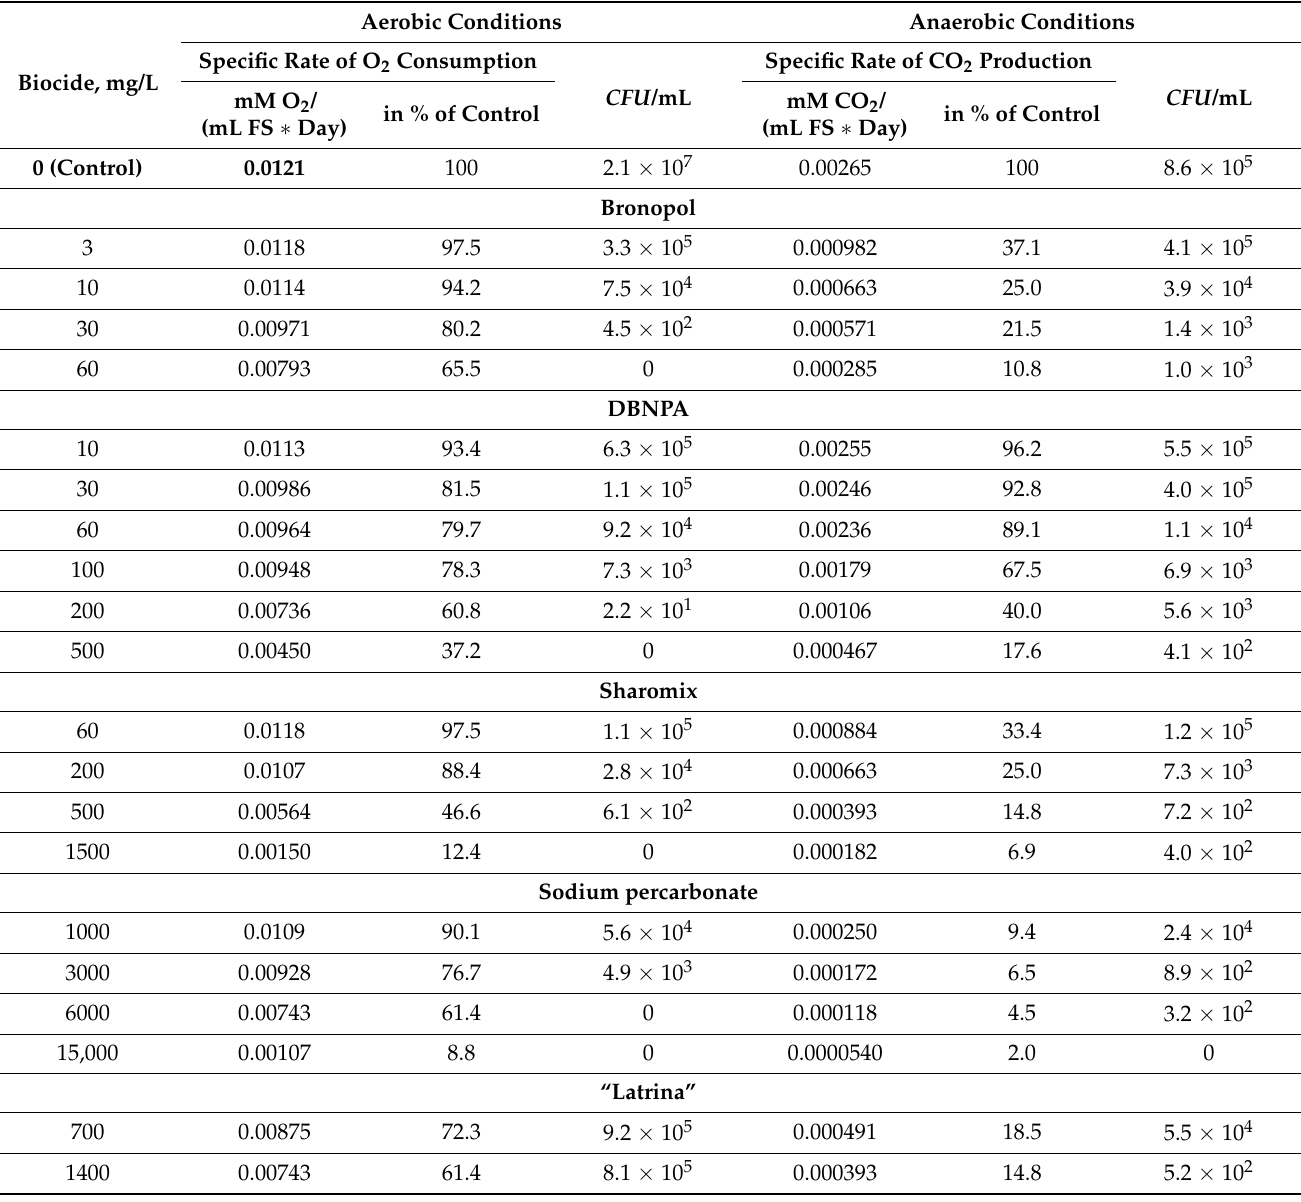
Table 7. Indicators of microbial activity in FS in the presence of biocides under aerobic and anaero- bic